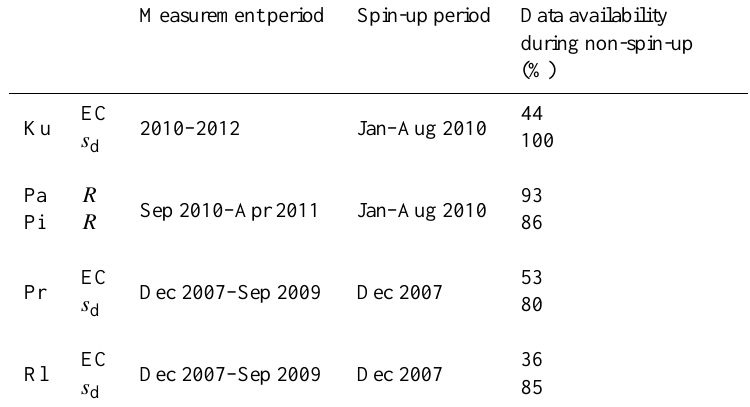
Table 2. Time period and the spin-up time of the model simulations. Data availability refers to the number of 60min periods when obser- vations are available for the non-spin-up period. EC is the eddy covariance fluxes ( Q H and Q E ) , R is the runoff and s d the snow depth. A sub-set of these data are used in parameter optimization and another for